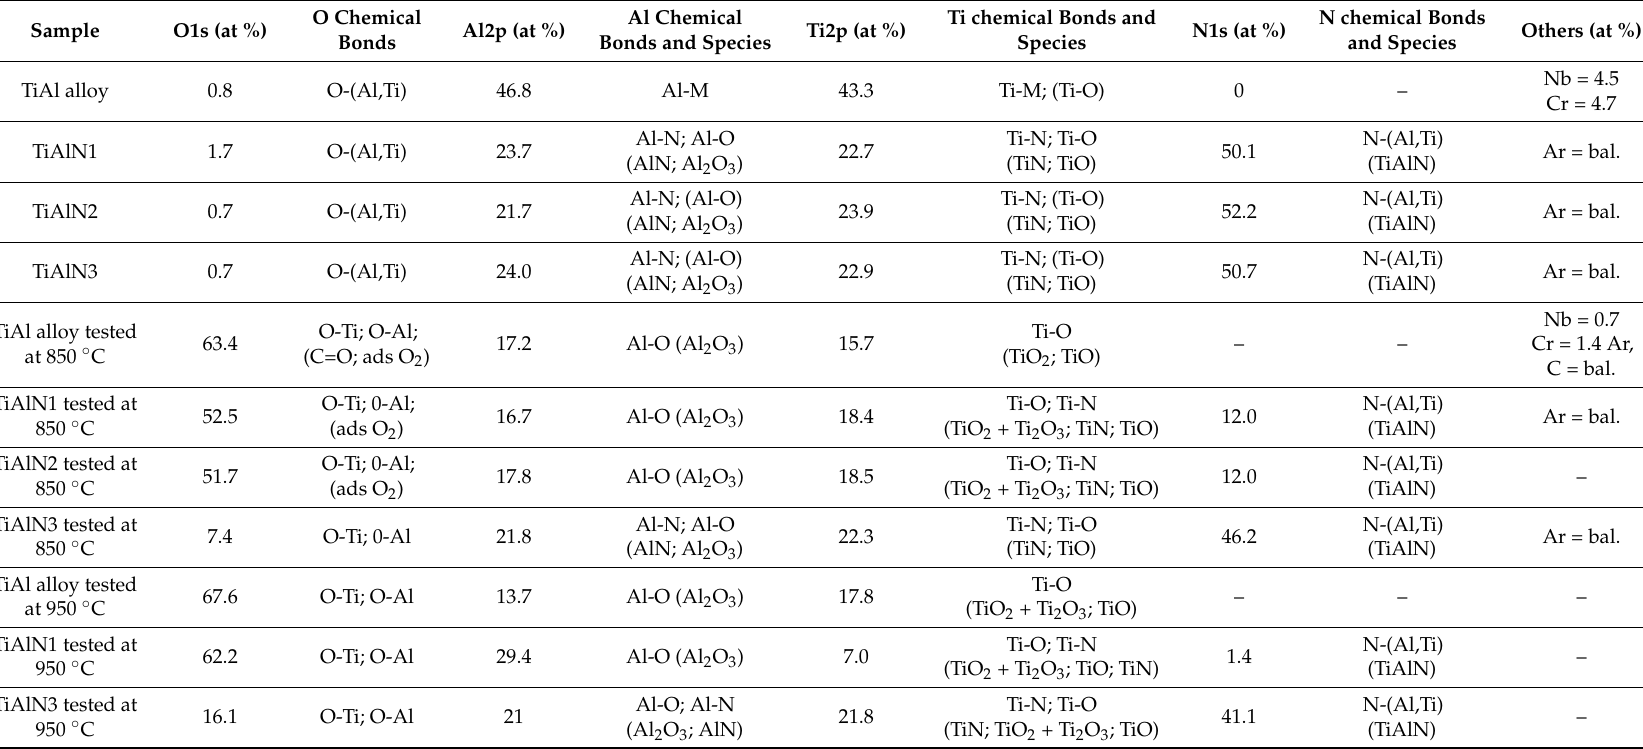
Table 2. XPS surface analysis of specimens before and after burner rig test (40 cycles up to 850 ◦ C and 950 ◦